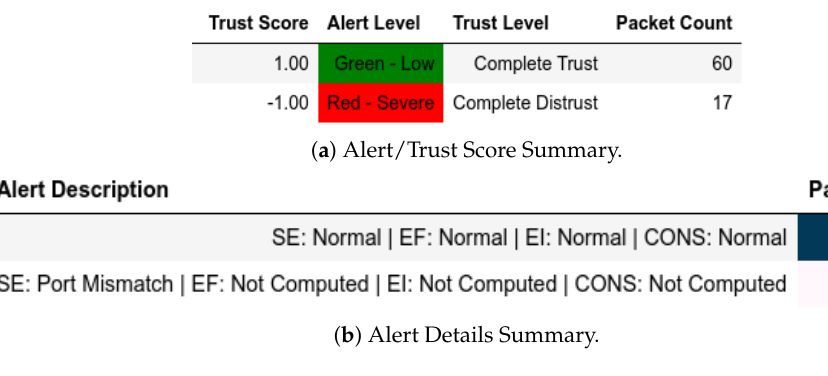
Figure 19. Client: EPM dataset internal Test- H s in moving files